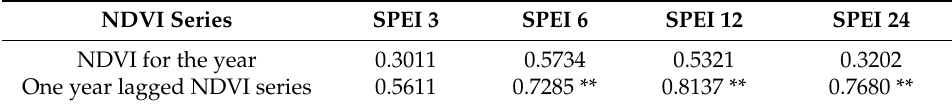
Table 3. The correlation of annual average NDVI and SPEI at multi-time scales.